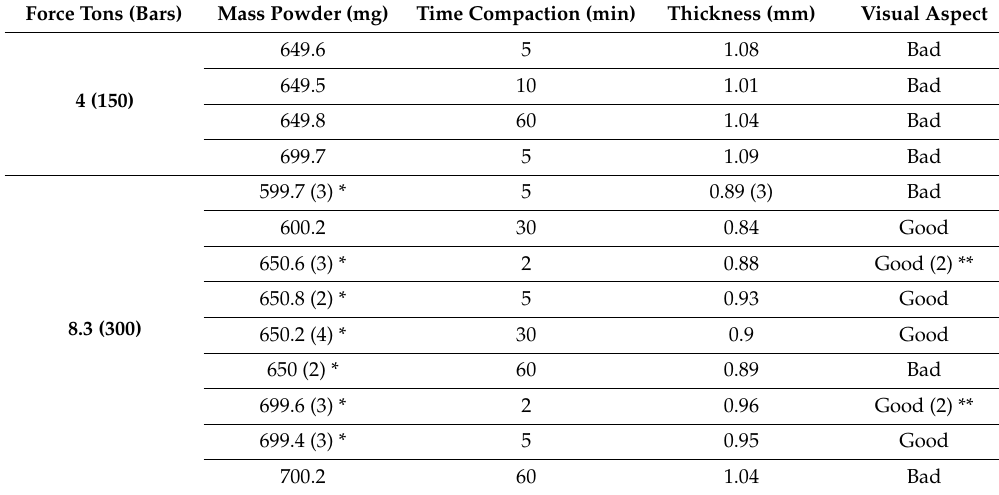
Table 6. different masses and thicknesses of the pellets.